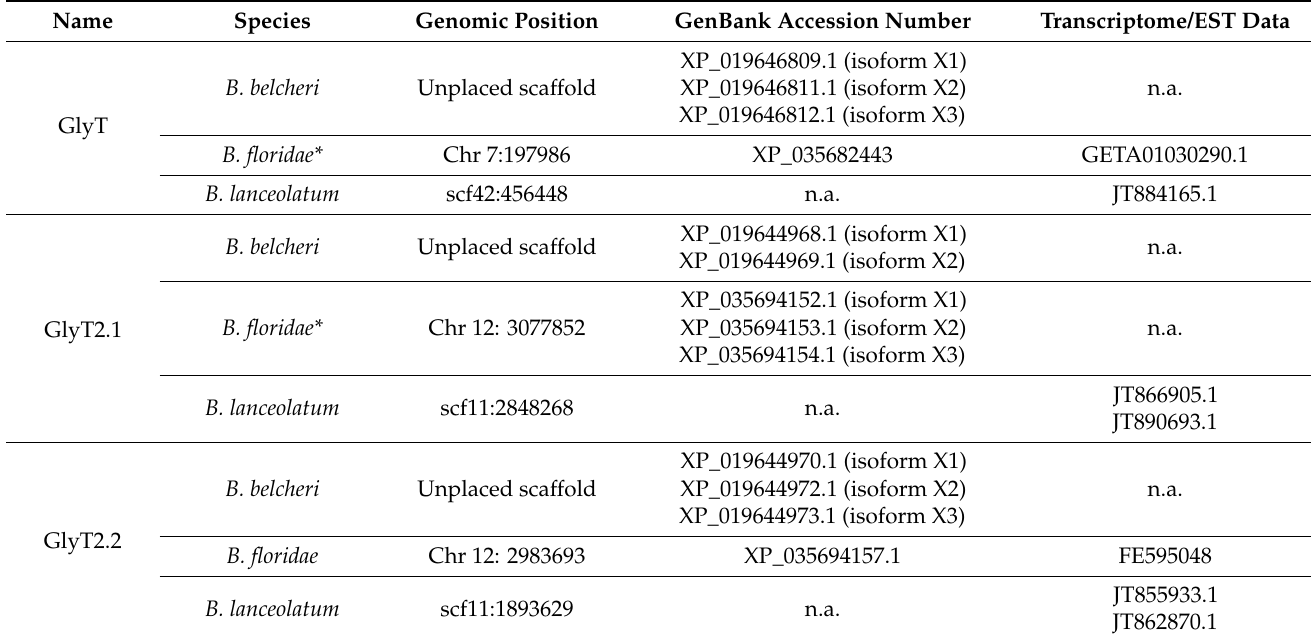
Table 1. List of cephalochordate glycine transporter sequences identified in this work (from Branchiostoma belcheri , Bran- chiostoma floridae , and Branchiostoma lanceolatum ). Glycine transporter sequences previously identified by Shpak and coworkers [31] are highlighted with an asterisk. n.a.: data not